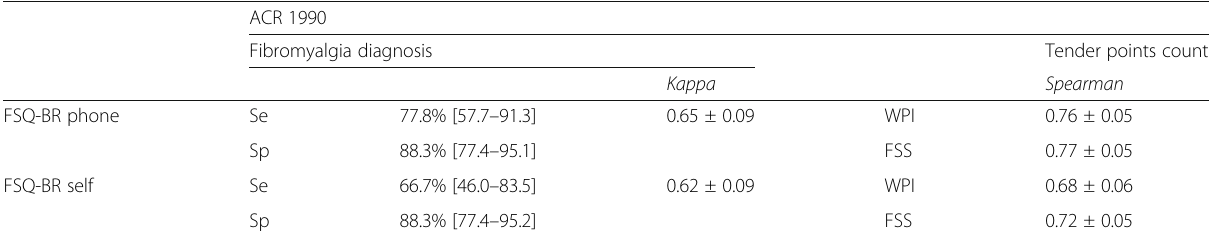
Table 3 Construct validity of Fibromyalgia Survey Questionnaire (Brazil): telephone interview and